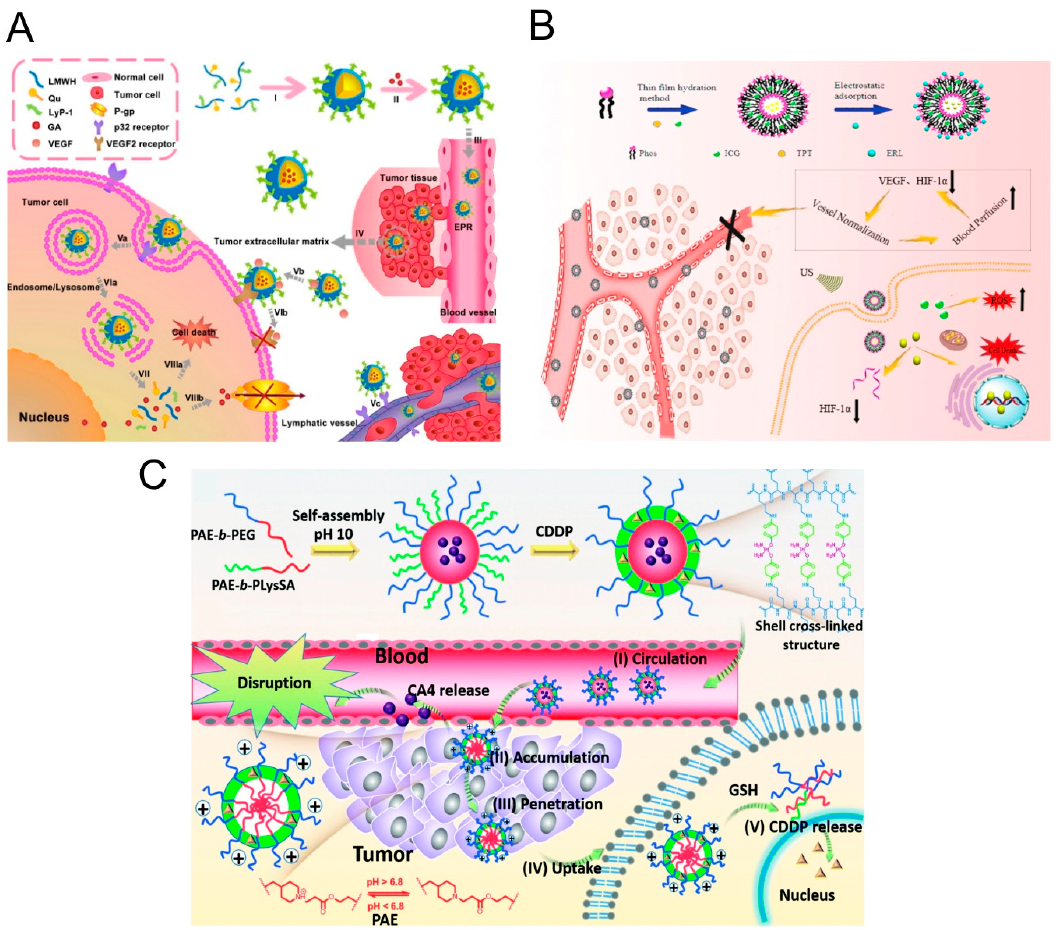
Figure 3. Antivascular therapy combined with nanoparticles enhances chemotherapeutic drug de- livery. ( A ) NPs@DA can affect endothelial cells and pericytes to normalize the structure of vessels and enhance the delivery of chemotherapeutic drugs to tumor cells. Treatment with the pH-sensitive NPs@DA system enhances the effect of therapy in mouse tumor models. Adapted with permis- sion [74]. Copyright © 2018 Elsevier Ltd. ( B ) Schematic illustration of efficient coencapsulation of